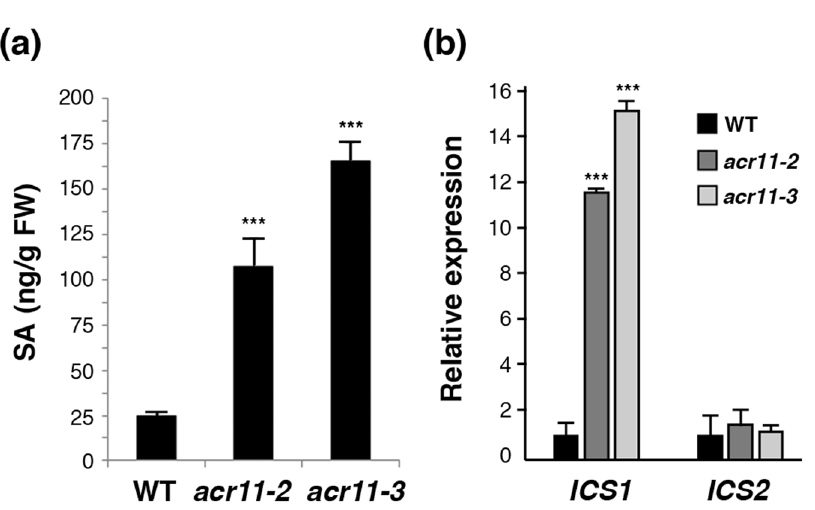
Figure 6. Enhanced salicylic acid (SA) accumulation is in the acr11 mutants. ( a ) Levels of free SA in the rosette leaves of 5-week-old Arabidopsis wild type (WT) and acr11 mutants. ( b ) Quantitative RT-PCR analysis of SA biosynthetic genes in the rosette leaves of 5-week-old Arabidopsis WT and acr11 mutants. The expression levels of ICS1 and ICS2 in WT were set at 1. Fold change indicates the relative expression of ICS1 and ICS2 as compared to that of WT. ICS , ISOCHORISMATE SYNTHASE . Results shown are means ± SD from three independent experiments. *** P < 0.001 represents the result of Student’s t